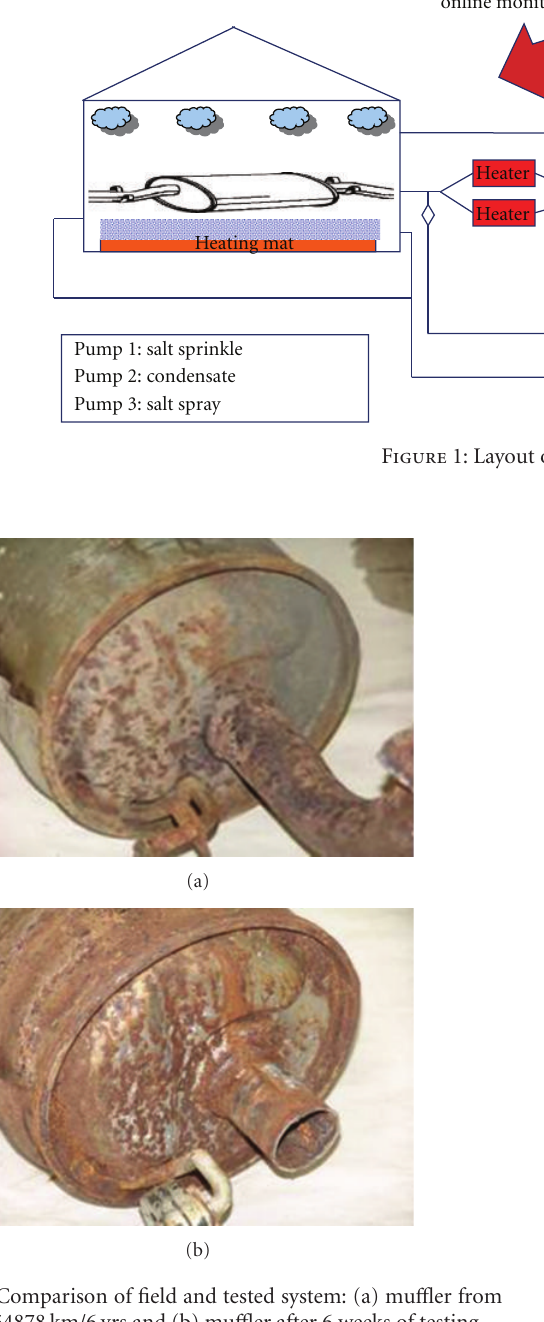
from field after 54878 km/6yrs and (b) mu ffl er after 6 weeks of